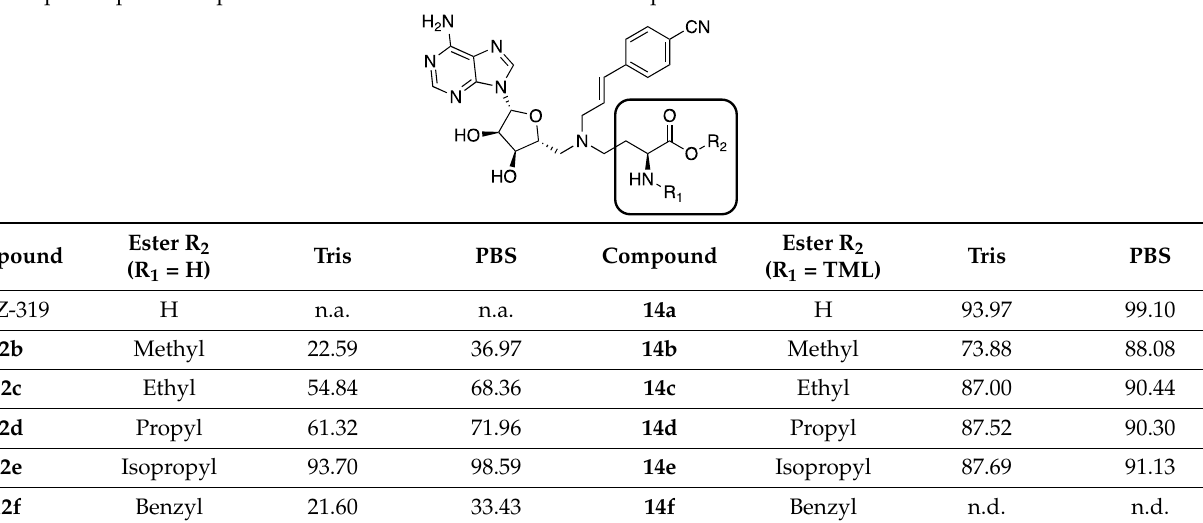
Figure 2. Esterase-mediated hydrolysis bisubstrate inhibitor prodrugs. ( A ) Hydrolysis of isopropyl ester prodrug 12e and ( B ) hydrolysis of isopropyl-TML dual prodrug 14e . The data show clean conversion of the prodrugs to the parent compound 17u . For the dual prodrug 14e , conversion of the TML happens first followed by the hydrolysis of the isopropyl ester moiety. 3.4. Cellular Assays With the suitability of prodrugs 12e and 14e established, the compounds were next tested using an MTT assay to evaluate their effect on cell viability in three different cancer cell lines: HSC-2 (oral cancer), T24 (bladder cancer), and A549 (lung cancer) (Figure 3). The results of these assays revealed that neither the reference NNMT inhibitor 6-methyl- amino-nicotinamide (6-MANA), nor prodrugs 12e or 14e or the parent GYZ-319, showed any appreciable effect on cell viability when tested at 1 and 10 µM concentrations. At the highest concentration tested of 100 µM, 6-MANA again showed no effect while the iso- propyl ester prodrug 12e showed an effect comparable to GYZ-319. By comparison, ad- ministration of compound 14e at 100 µM did cause a time dependent reduction in cell 0,00 1,00 2,00 3,00 4,00 5,00 6,00 7,00 8,00 9,00 10,00 11,00